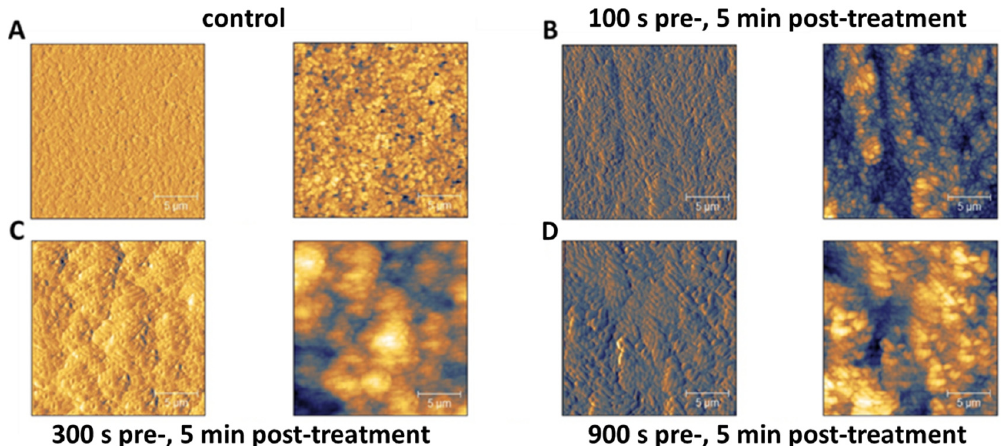
Figure 6. Atomic force microscopy (AFM) images of P. fluorescens biofilms. Left) topographical images right) error images. The pretreatment time defines the time period in which the water came into contact with the plasma gas. The post-treatment time represents the period of time, where the PTW came into contact with the biofilm. ( A ) Control biofilm ( B ) 100 s pretreatment, 5 min post-treatment ( C ) 300 s pretreatment, 5 min post-treatment ( D ) 900 s pretreatment, 5 min post-treatment.